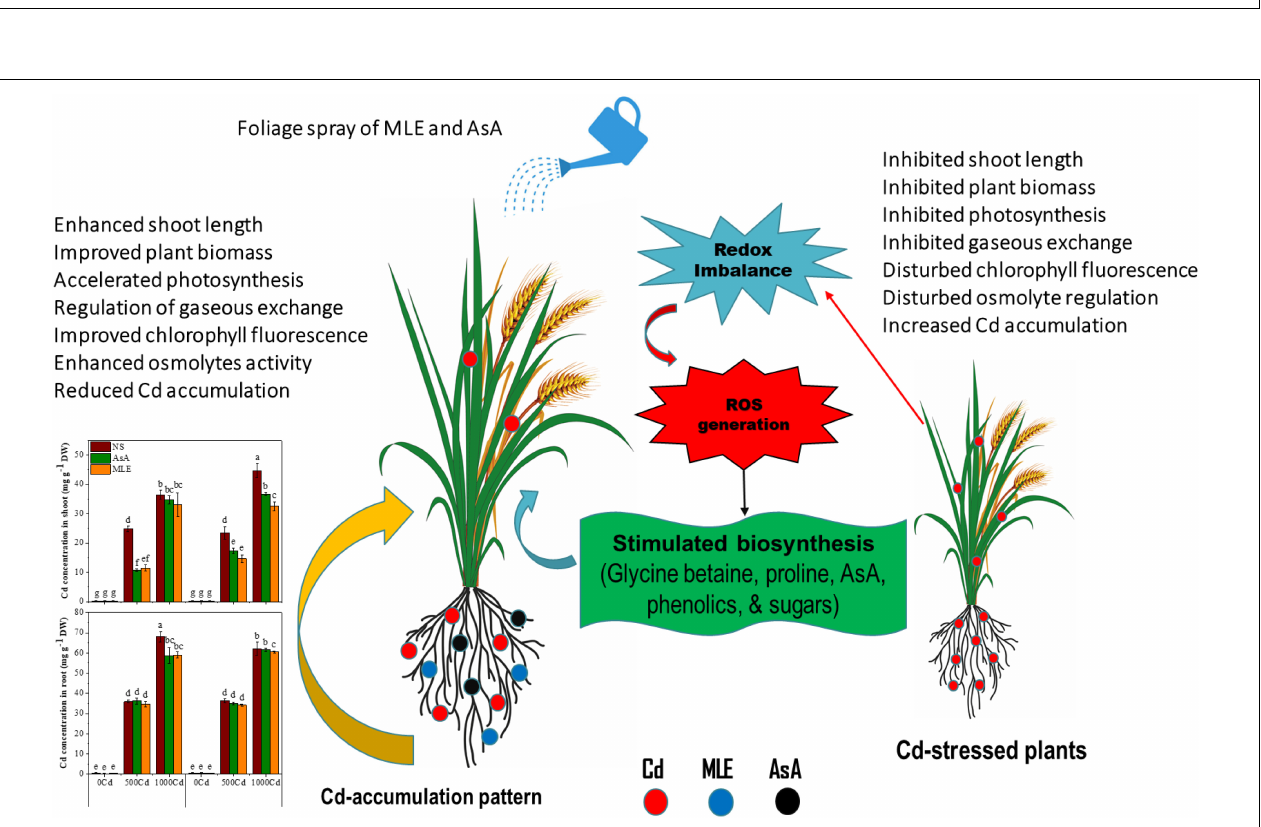
FIGURE 7 | The schematic diagram exhibiting the beneficial role of AsA and MLE against Cd-induced phytotoxicity in wheat seedlings.